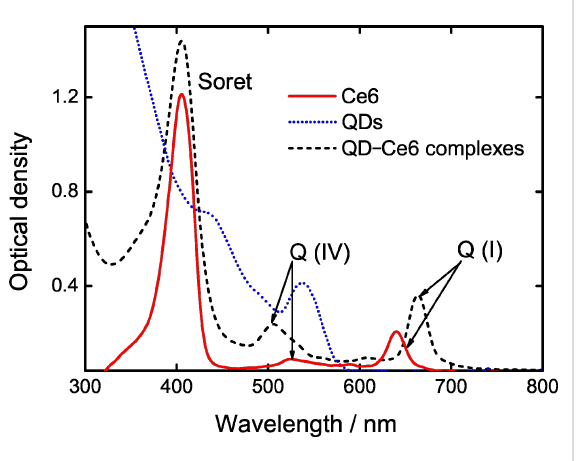
Figure 3: The PL spectra of covalent QDs–Ce6 complexes excited at 475 nm (solid line) and 640 nm (dotted line). The Ce6 PL intensity is normalized to optical density at excitation wavelength. The PL spec- trum of QDs excited at 475 nm (dashed line) is shown for